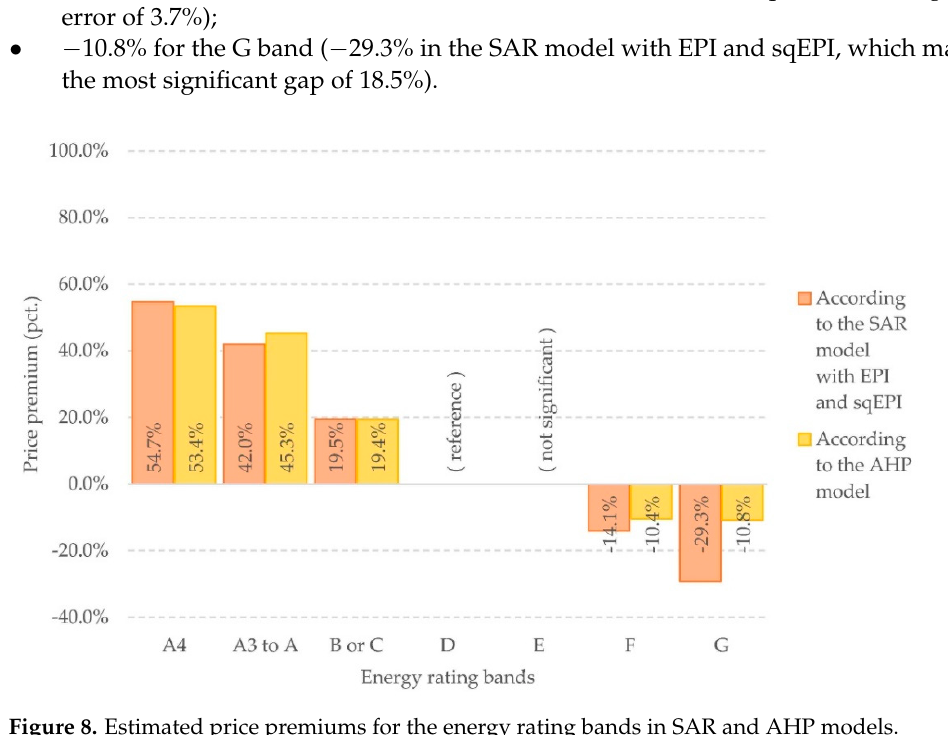
Figure 8. Estimated price premiums for the energy rating bands in SAR and AHP models.